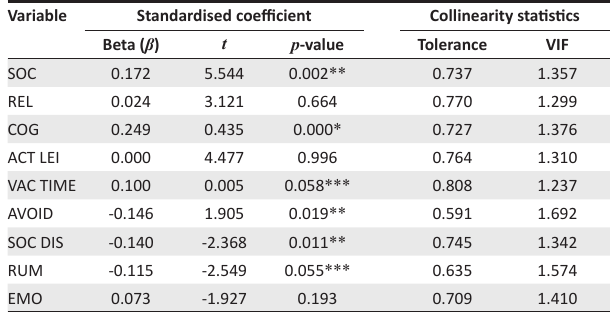
TABLE 4: Multiple regression analysis ( n =